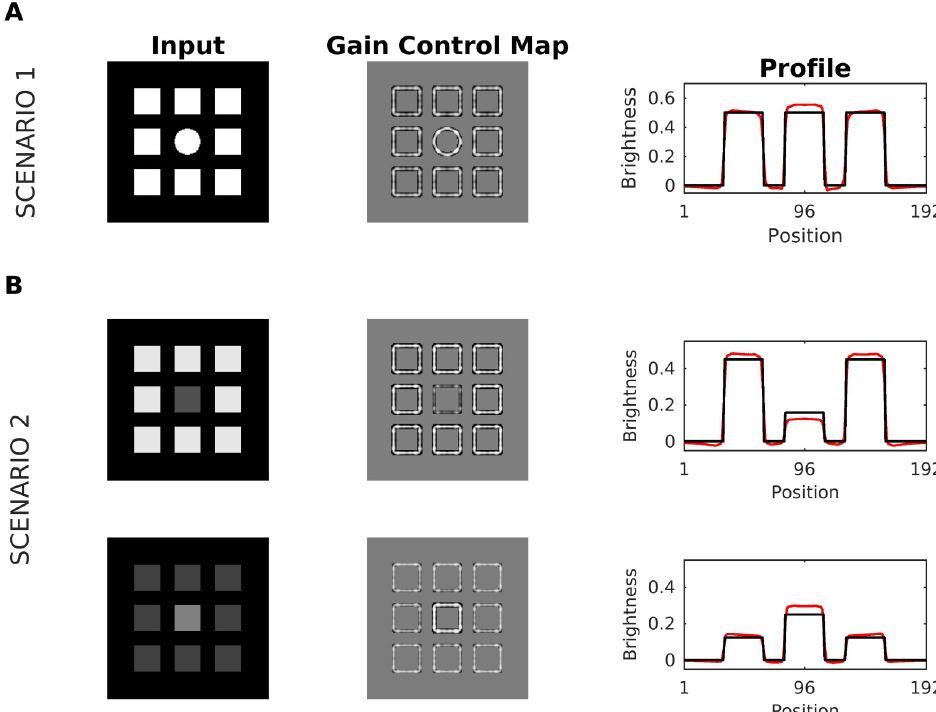
Fig 7. Scenario 1 and scenario 2. (A) Scenario 1: A disk embedded in a redundant pattern of eight squares served as input (first column). The middle column depicts the corresponding gain control map G, and the right column the profiles of input (black line) and brightness estimation (red line). The brightness of the center disk ts enhanced with respect to luminance, meaning that a brightness contrast effect is predicted merely based on redundancy (but not on grounds of luminance—note that all features have the same luminance). (B) Scenario 2. (Top) The input consists of a series of nine squares arranged in a spatially redundant pattern, where the middle square has a different luminance. The profile plot suggests an overall increase in brightness contrast: Brightness of the middle square is further reduced, while the brightness of the surrounding squares is enhanced. (Bottom) While the brightness contrast also increased in the display with the bright middle square, this increase in contrast is caused nearly exclusively by the middle